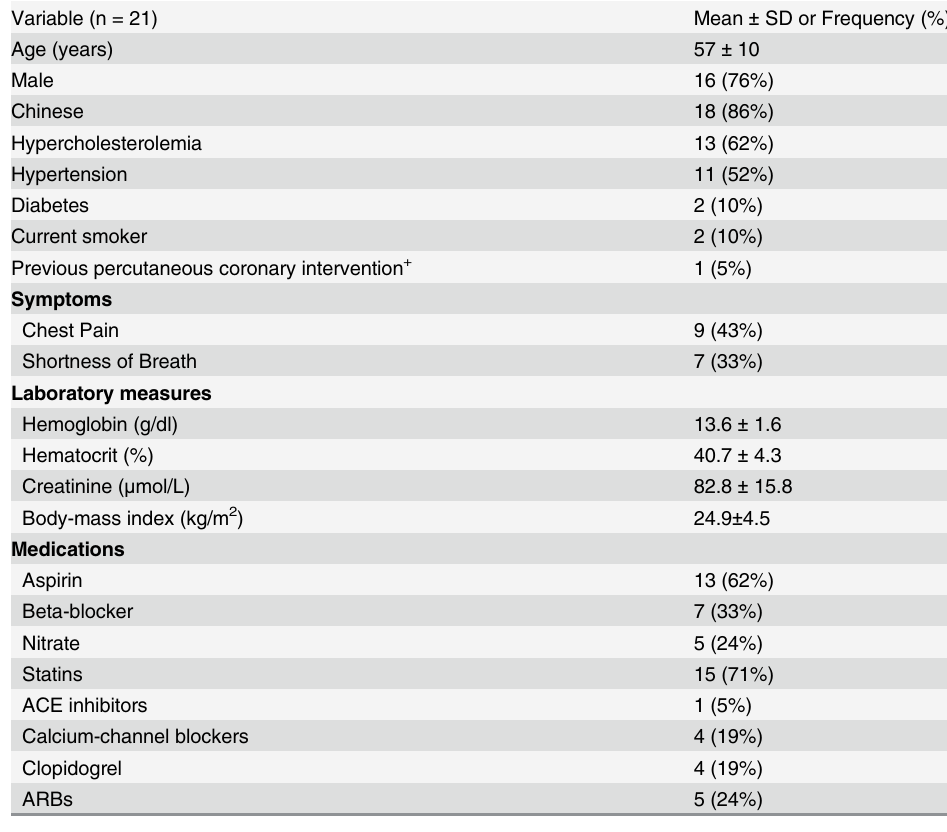
Table 1. Baseline